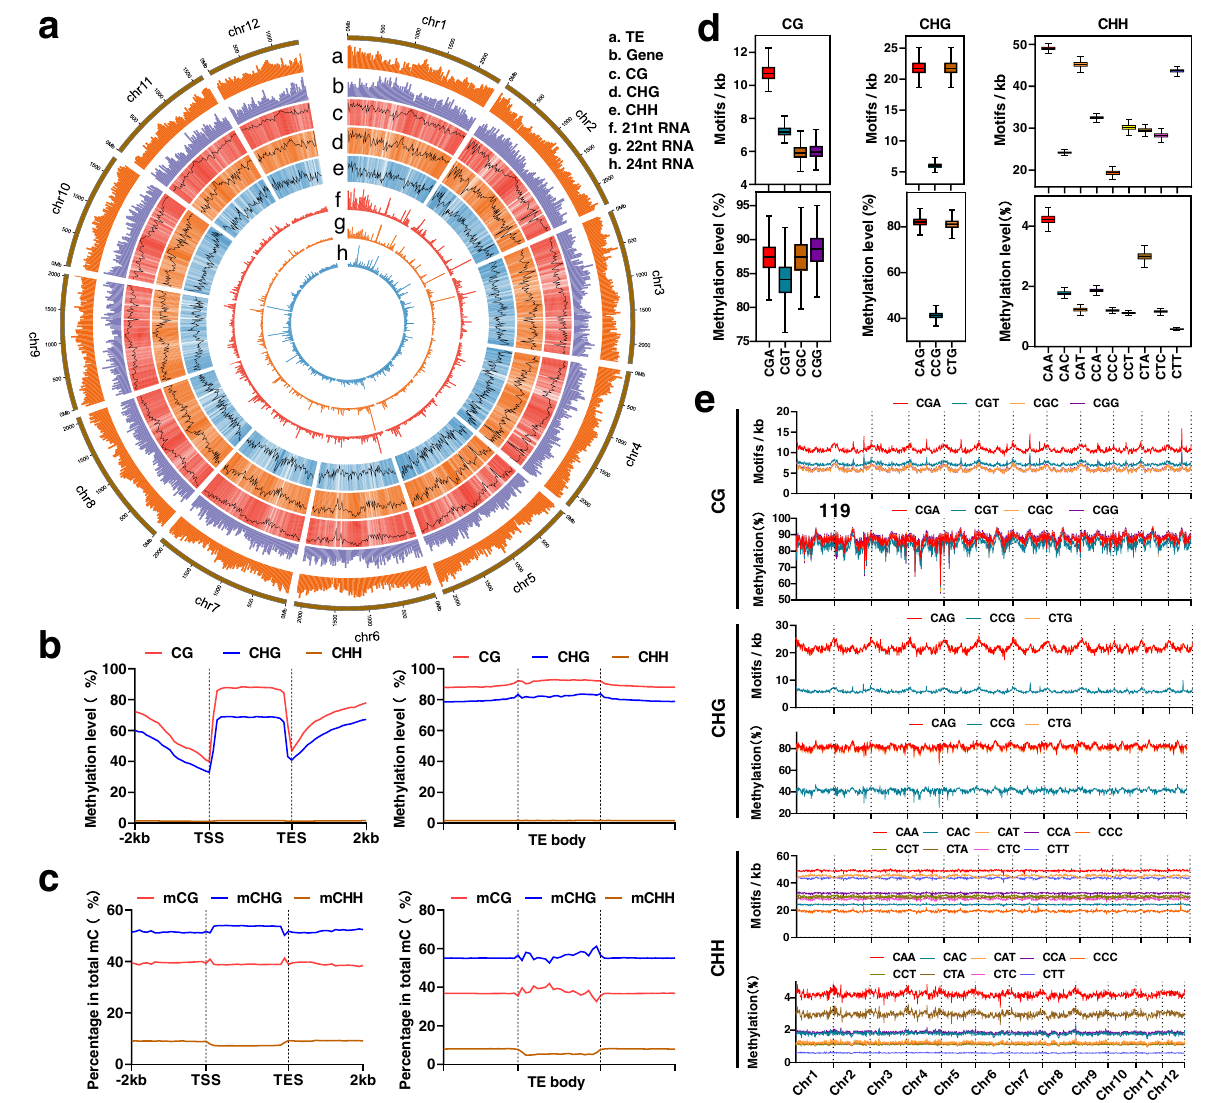
Fig. 1 | Characterization of the DNA methylome of Chinese pine ( Pinus tabuli- formis ). a Methylation features depicted by using 20-Mb-wide bins across the 12 chromosomes. Units on the circumference show megabase values. Track a, repeat coverage. Track b, gene density. Track c, CG methylation level. Track d, CHG methylation level. Track e, CHH methylation level. Track f, 21-nt siRNA density. Trackg,22-ntsiRNAdensity.Trackh,24-ntsiRNAdensity. b DNAmethylationlevels of CG, CHG, and CHHfor genes and TEs. c PercentagesofmCG, mCHG and mCHH for genes and TEs. Value iscalculated asthe number of mC divided by the number